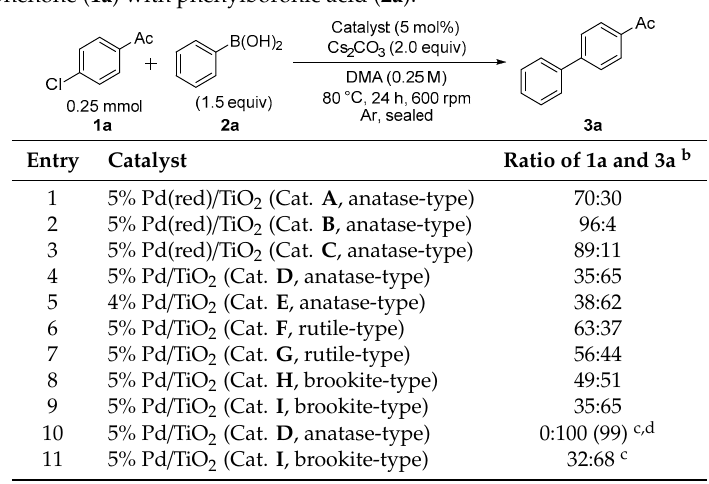
Figure 1. X-ray photoelectron spectroscopy (XPS) spectra of 5% Pd/TiO 2 (Cat. D and F – I ) and 4% Pd/TiO 2 (Cat. E ). Table 2. Catalyst activity of TiO 2 -supported Pd catalysts for the Suzuki–Miyaura coupling reaction of 4 ′ -chloroacetophenone ( 1a ) with phenylboronic acid ( 2a ).